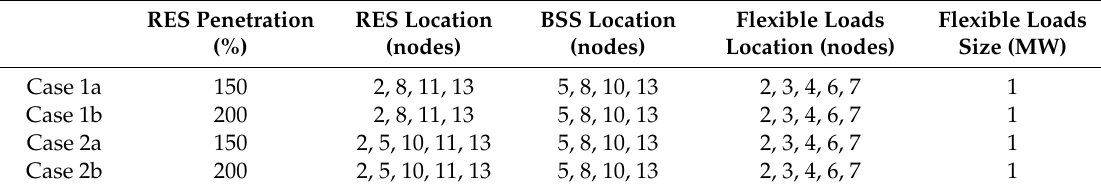
Table 1. High RES penetration Scenario—Summary Table.